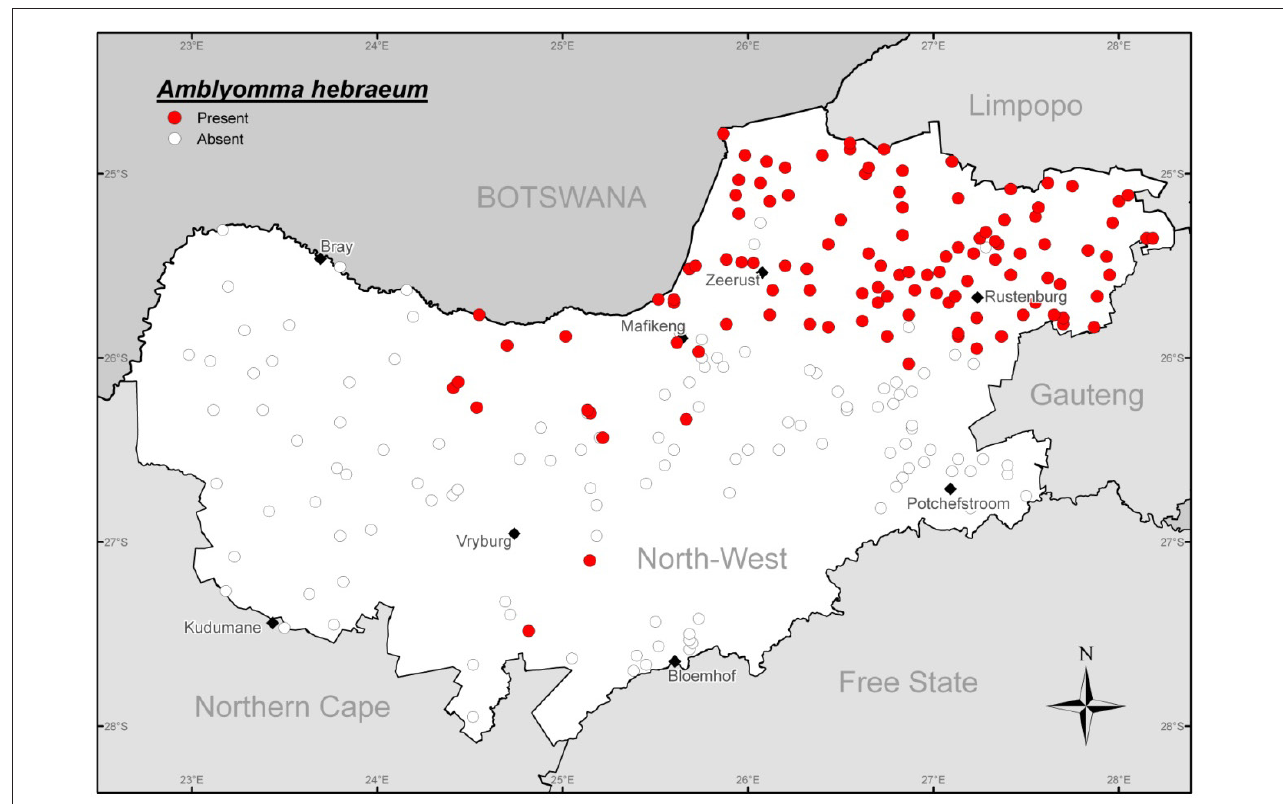
FIGURE 3: The geographic distribution of Amblyomma hebraeum in the North West province, South Africa. goats; 0.8 % were not assigned a host. H. truncatum accounted for only 2.3 % of the total number of specimens